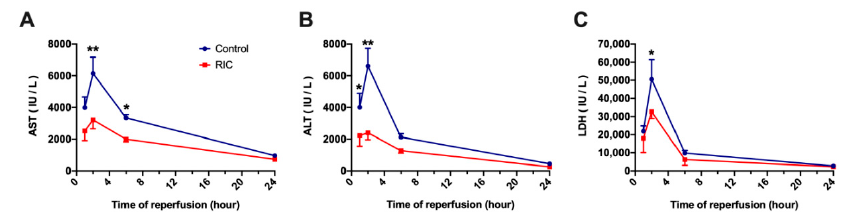
Figure 3. Markers of cellular injury. ( A – C ) Time course of transaminases and LDH demonstrated the peak of injury after 2-h of reperfusion. The application of iRIC significantly reduced transaminase and LDH release, especially during the acute phase of reperfusion (mean ± s.e.m., * p < 0.05, ** p < 0.01, RIC vs. Control, two-way ANOVA and Bonferroni post-hoc test, n = 5 / group / time point). Abbreviations used: AST—Aspartate aminotransferase; ALT—Alanine aminotransferase; LDH—Lactate dehydrogenase; RIC—Remote ischemic conditioning.